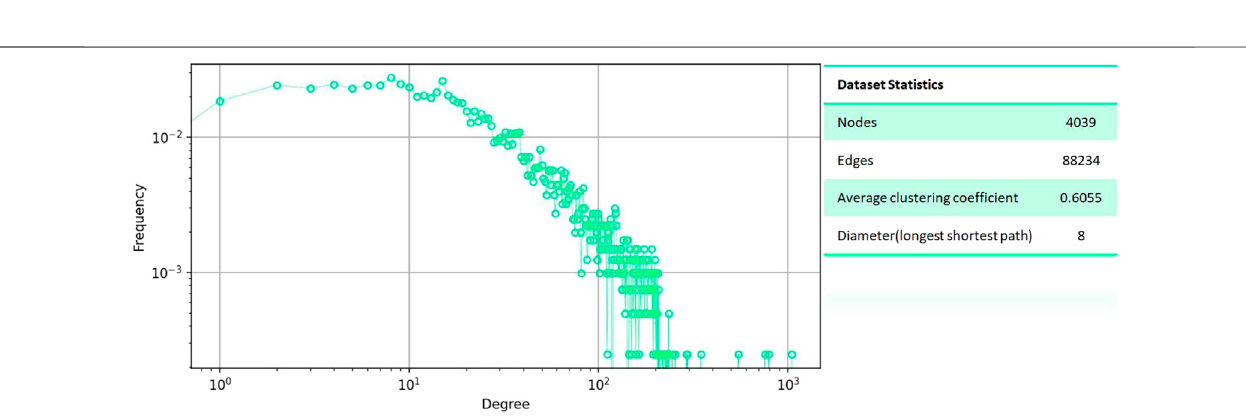
FIGURE7| MainstatisticalpropertiesoftheFacebookonlinesocialnetwork.TheURLtoobtainthisnetworkdataishttp://snap.stanford.edu/data/ego-Facebook. html.